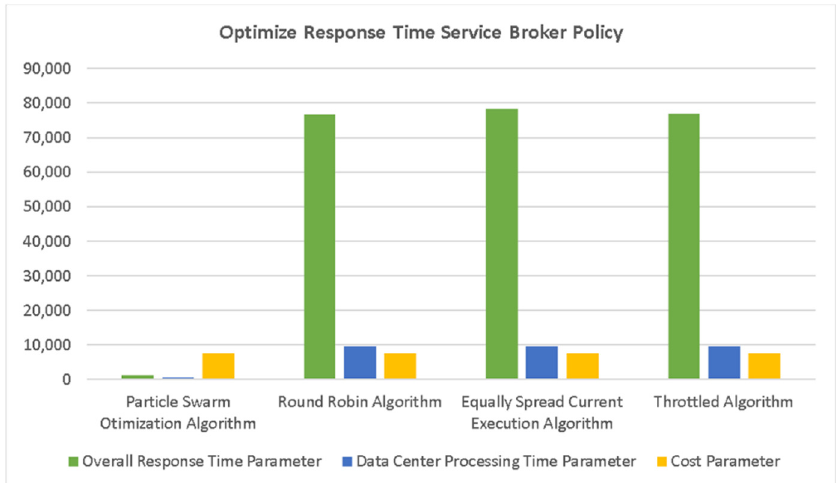
Figure 16. The comparison of PSO, RR, ESCE, and throttled algorithms by considering the parame- ters based on the optimizing response time SBP.